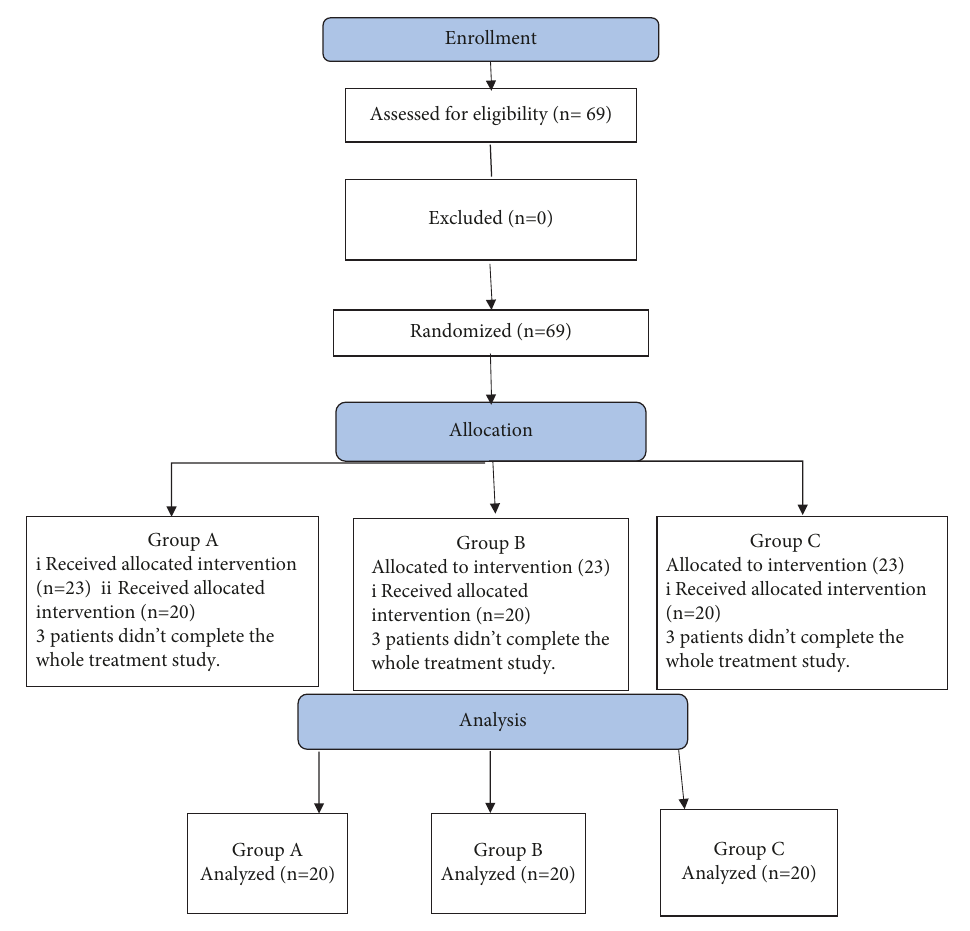
Figure 1: Participant’ fow